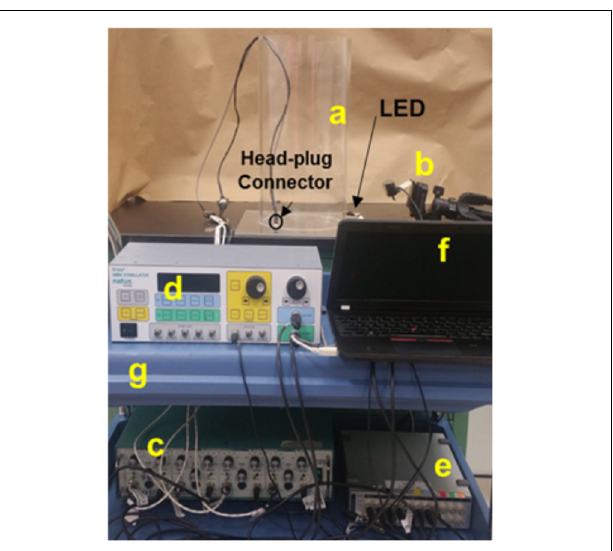
FIGURE 3 | Mobile experimental setup utilizing the closed-loop spinal ES system. Picture of the experimental setup for an individual rat shows an acrylic cylinder used for obtaining EMG data during grooming and rearing behaviors (a) , camera (b) , amplifier (c) , stimulator (d) , DAU (e) , and laptop (f) , all situated on a mobile cart (g) . The camera setup is particularly different than the non-mobile experiments and the setup is handy for training and testing in short